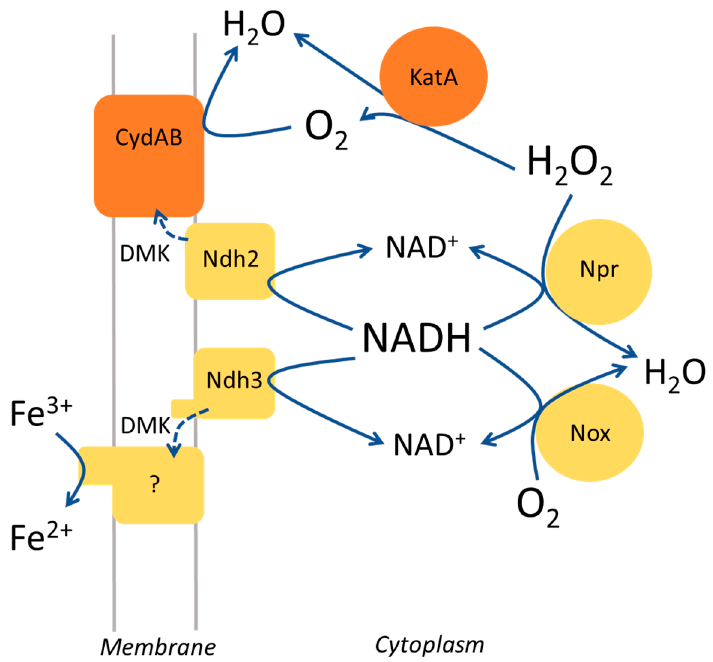
Figure 4. Schematic drawing presenting the roles of enzymes in E. faecalis relevant in this study. CydAB, cytochrome bd ; DMK, dimethylmenaquinone; KatA, catalase; Npr, NADH peroxidase; Ndh, NADH dehydrogenase; Nox, NADH oxidase. Dotted lines indicate electron transfer. Cytochrome bd and catalase are only assembled and functional when heme is provided in the growth medium [4]. The function of the membrane-associated NADH dehydrogenase Ndh3 is devoted to EET, whereas that of Ndh2 seems to be in respiration with molecular oxygen [14]. Proteins that function in the electron transfer from reduced DMK to extracellular ferric ions are not known at present and this is indicated by a question mark.